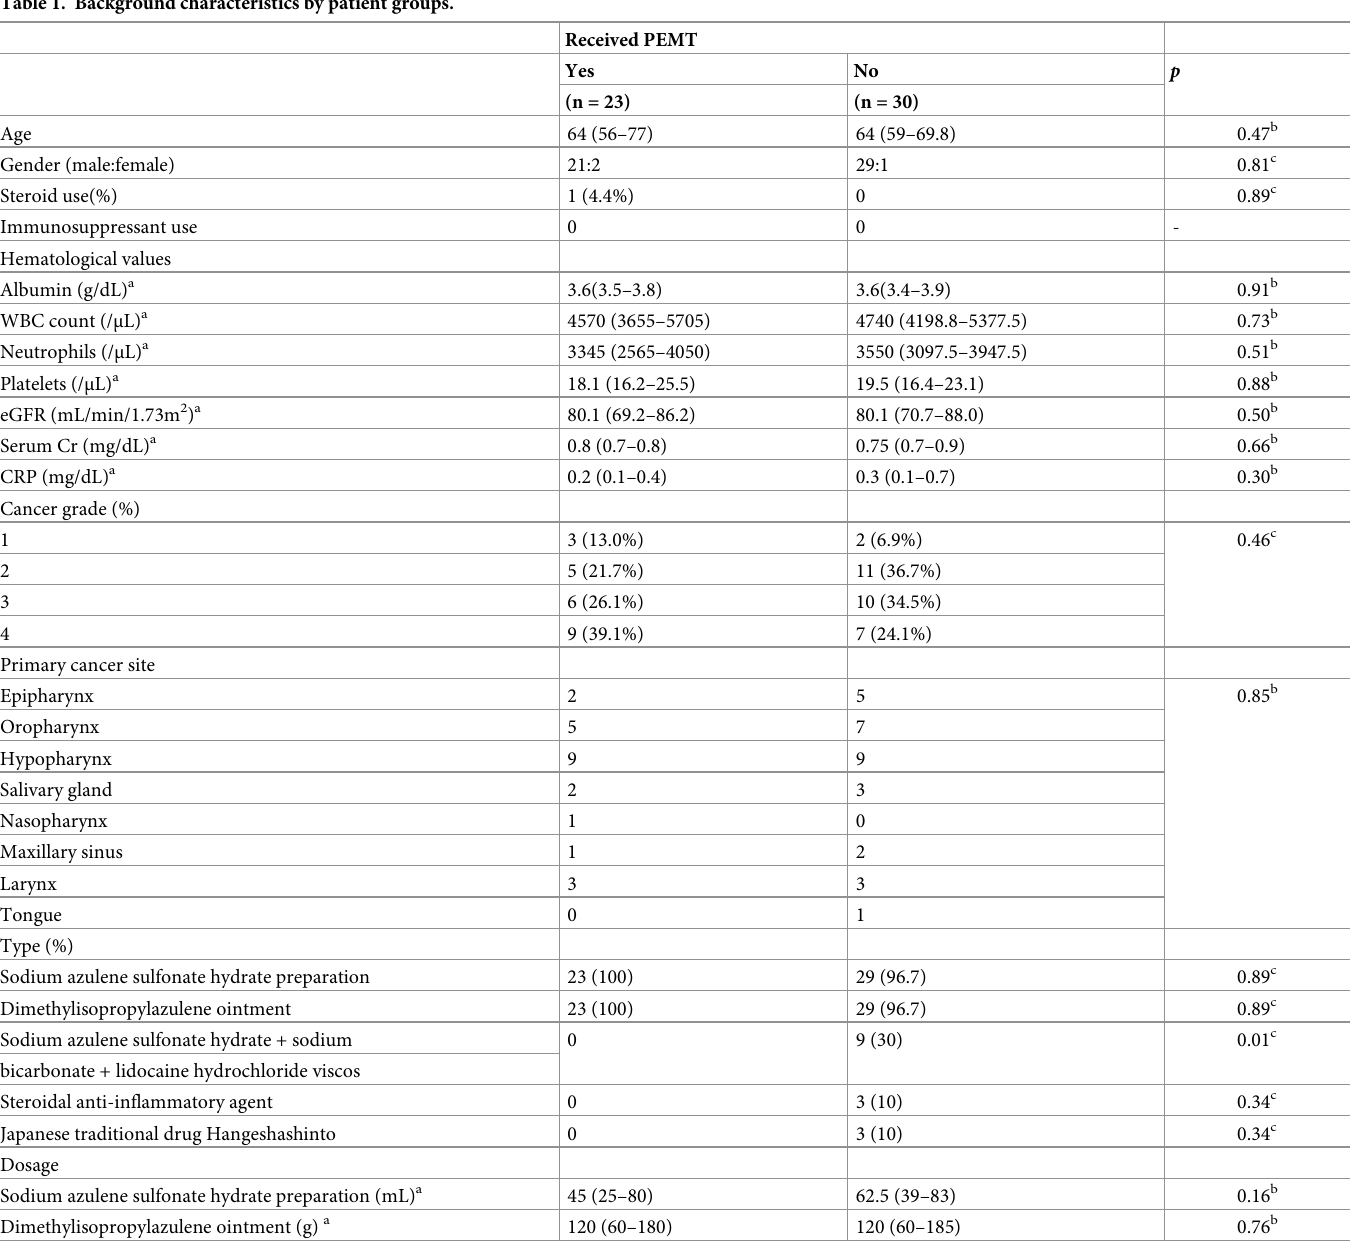
Table 1. Background characteristics by patient